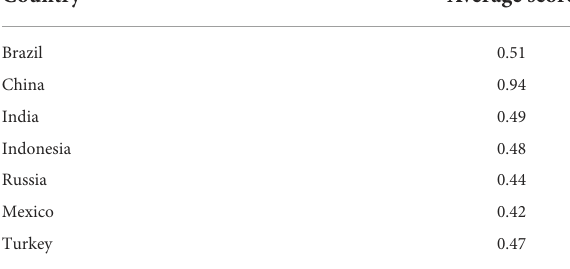
TABLE 4 Average EPI